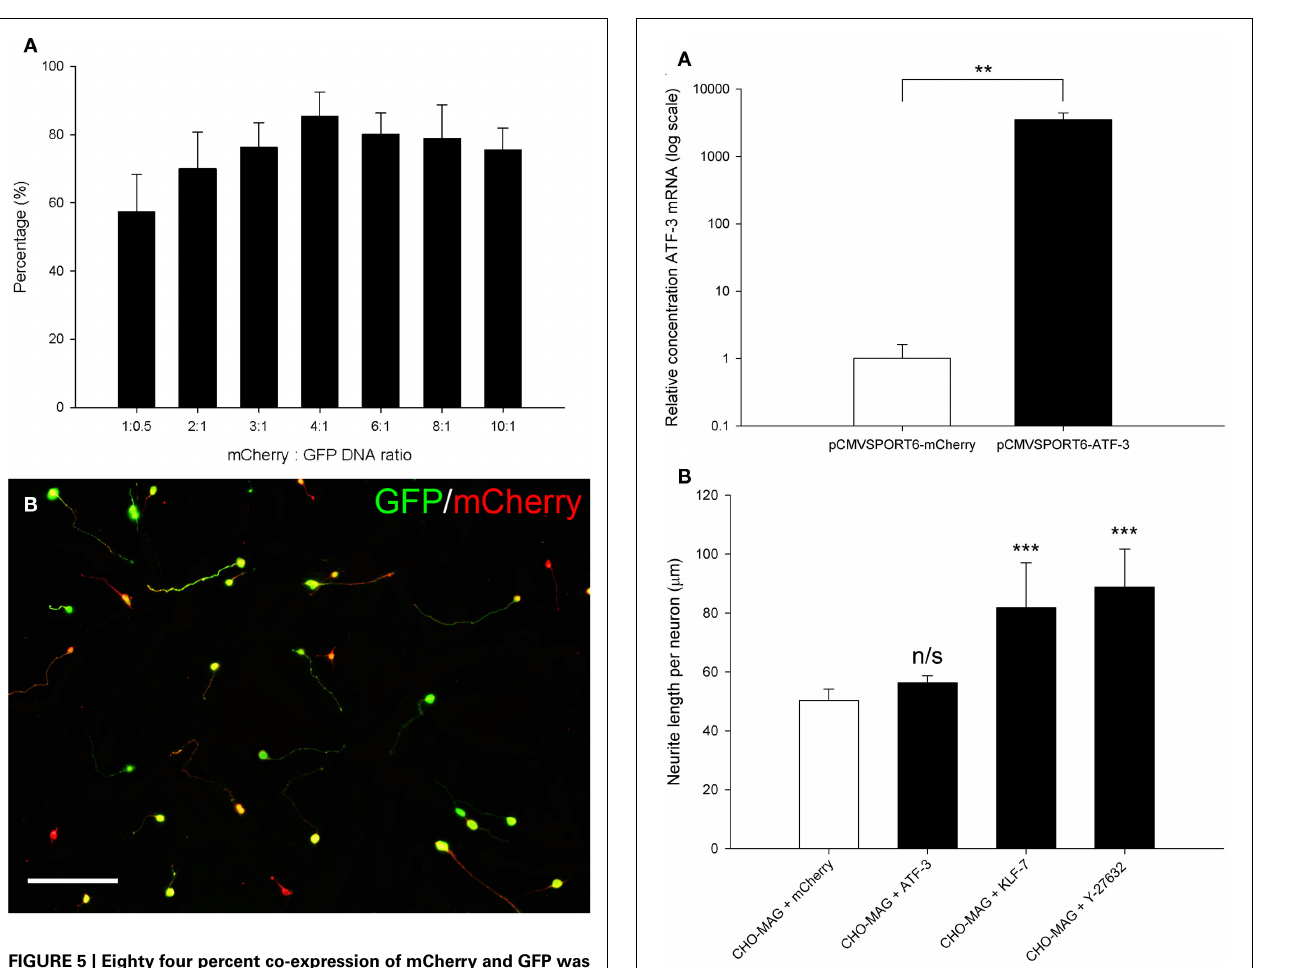
FIGURE 5 | Eighty four percent co-expression of mCherry and GFP was obtained using a 4:1 DNA ratio. (A) Quantification of the percentage of cells co-expressing GFP and mCherry.The percentage of cells co-expressing both fluorescent proteins increased with the ratio of mCherry to GFP, peaking at a ratio of 4:1 where 84% of the GFP expressing cells also expressed mCherry.Values represent mean and SD, n = 8. (B) CGNs co-transfected with mCherry and GFP using a ratio of 4:1. CGNs co-expressing GFP (green) and mCherry (red) appear yellow. Scale bar: 100 μ m.